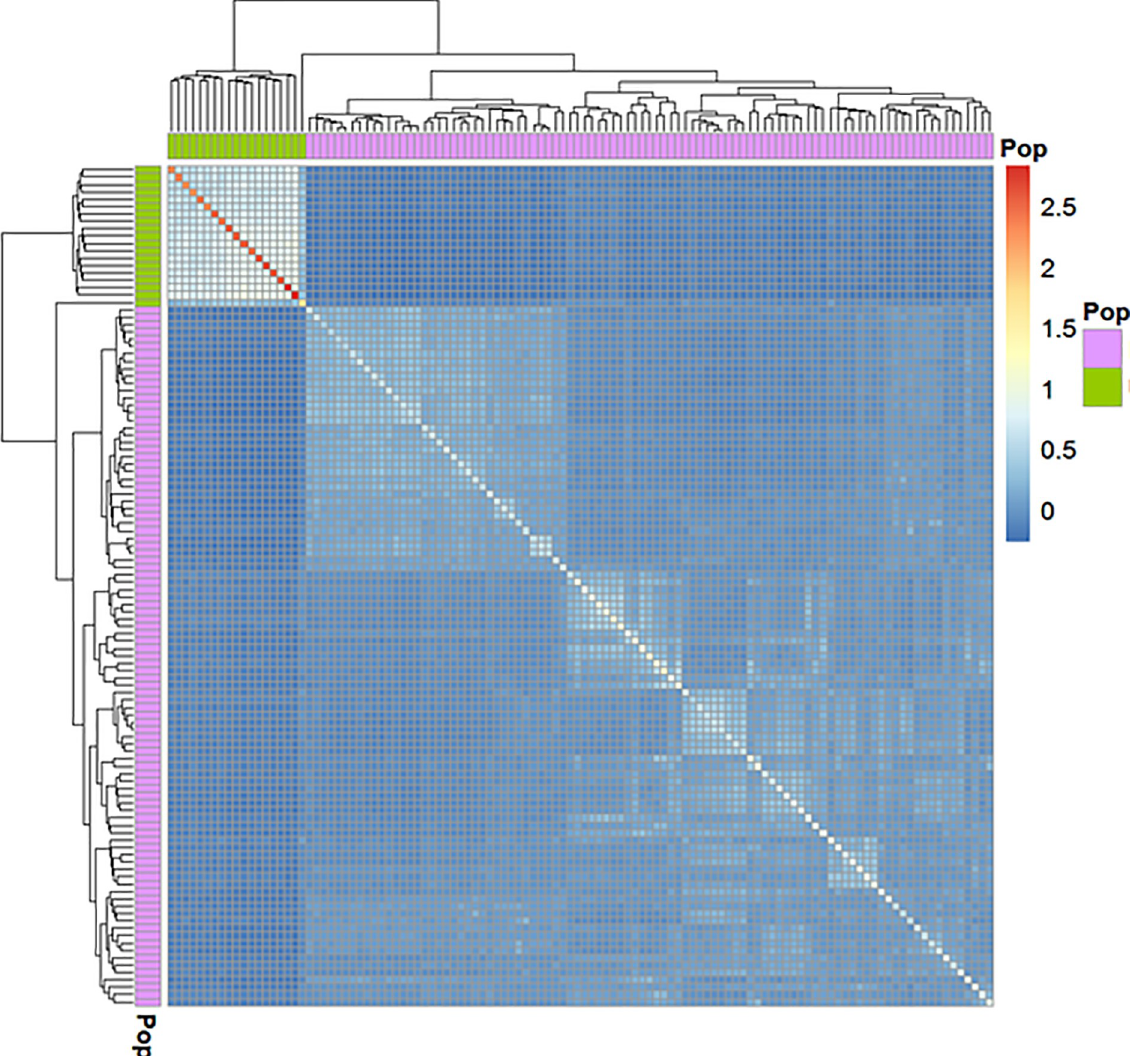
Fig 4. Sorghum panel genomic relatinship matrix. Heatmap displaying relationships among the 114 sorghum genotypes used in the GWAS. Pink and green colors identify, respectively, Sorghum bicolor and S . bicolor × S . halepense populations. The white diagonal represents perfect relationship of each genotype with itself; sections of warmer colors in the diagonal represent excess heterozygosity; the symmetric off-diagonal elements represent relationship for pairs of genotypes. The blocks of light colors on the diagonal show clusters of closely related genotypes. The adjoining dendrogram illustrates Kinship groups identified in the sorghum